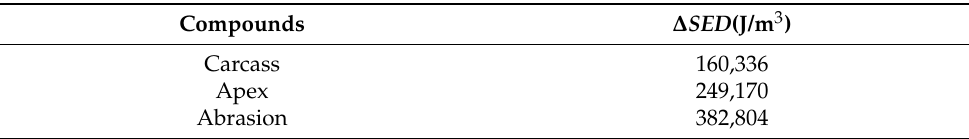
Table 2. Maximum strain energy density range of rubber compounds.